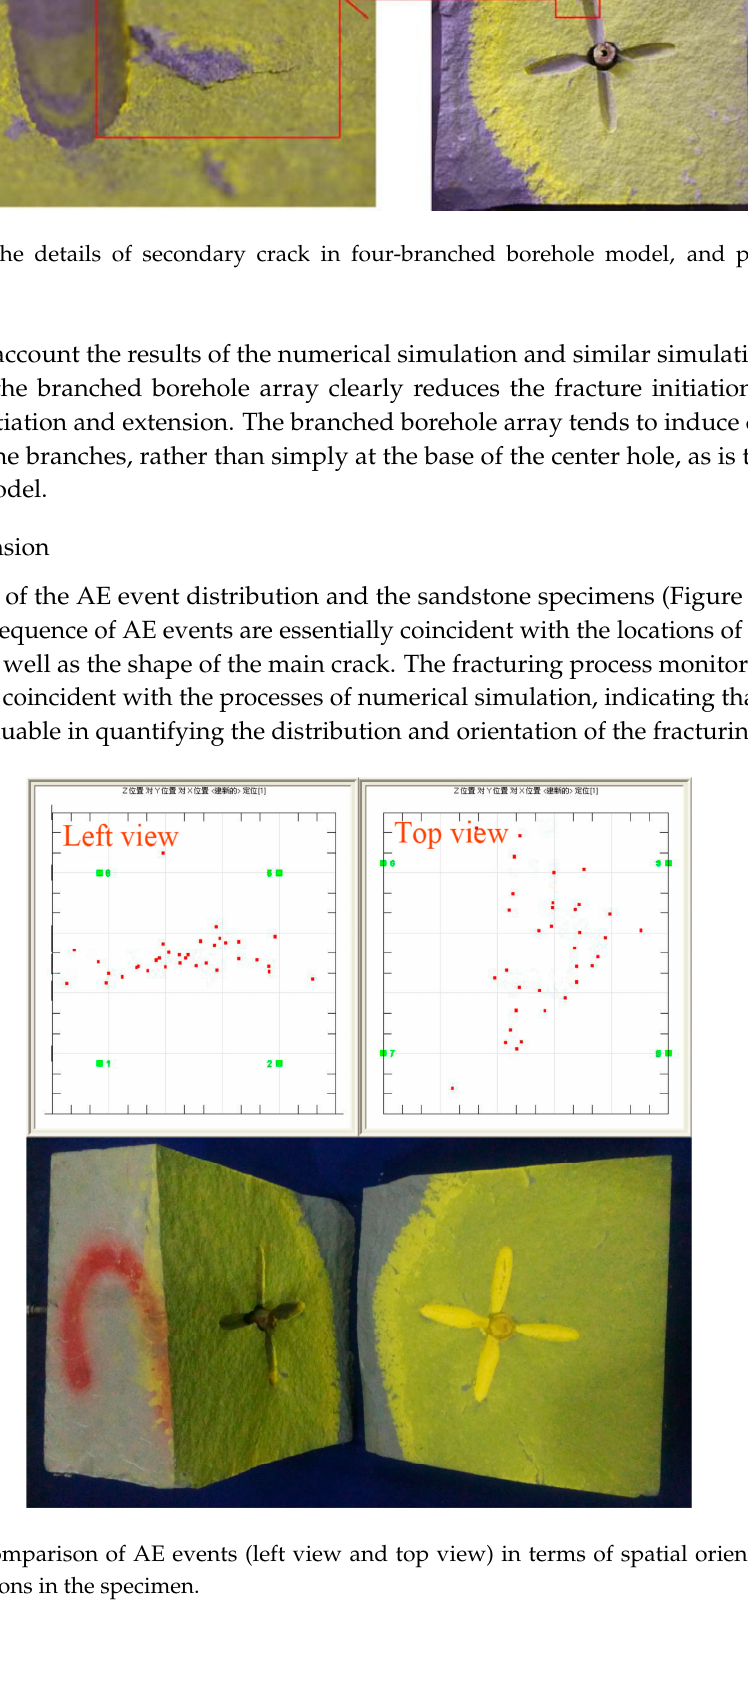
Figure 12. Comparison of AE events (left view and top view) in terms of spatial orientation, and fracture positions in the specimen.